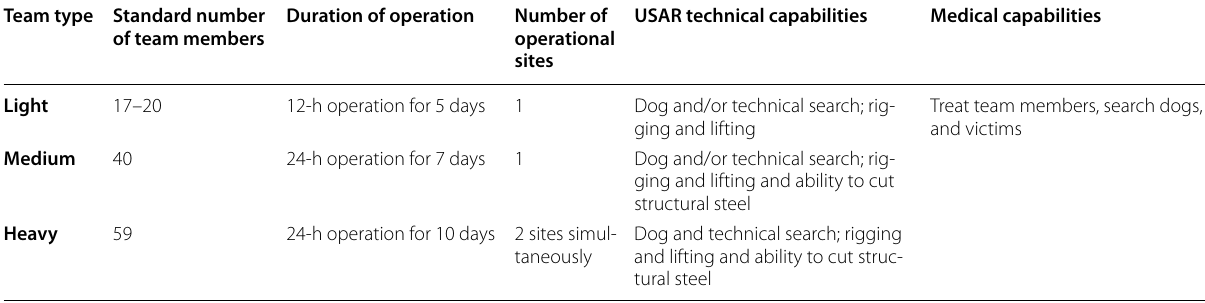
Team type Standard number Duration of of team members